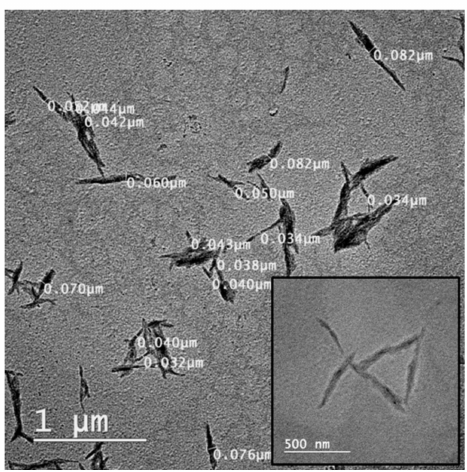
Figure 2. TEM images of cellulose nanocrystalsisolated from plum seed